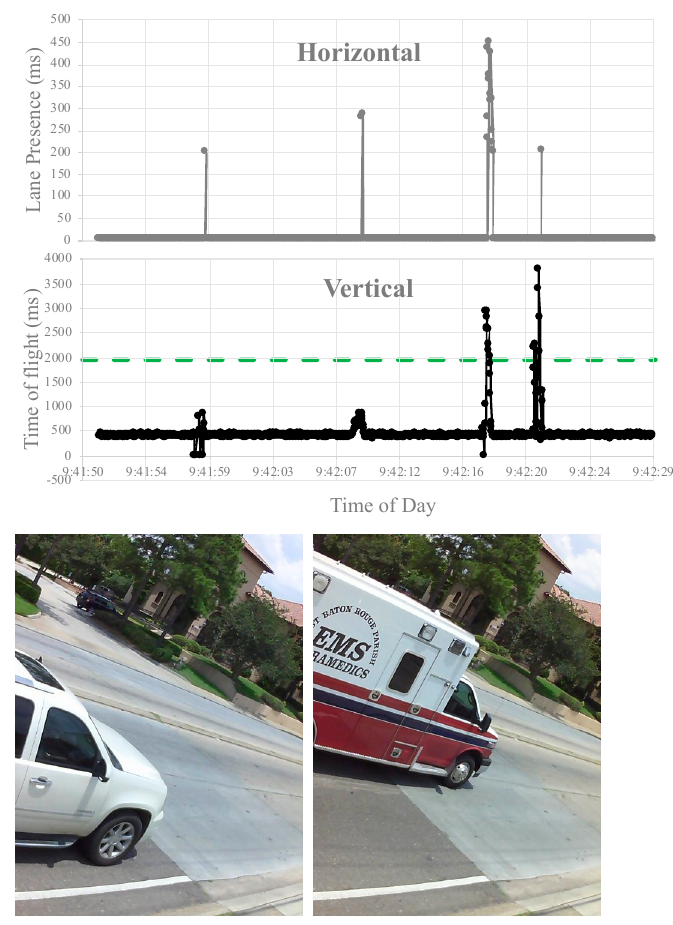
Figure 7. Sample data obtained from vertical and horizontal sensors, identifying height and presence, respectively ( top ). Intersection between both sensing subsystems indicates the system that a vehicle profile must be logged. Resulting images and vehicle characteristics are then calculated and stored ( bottom ).